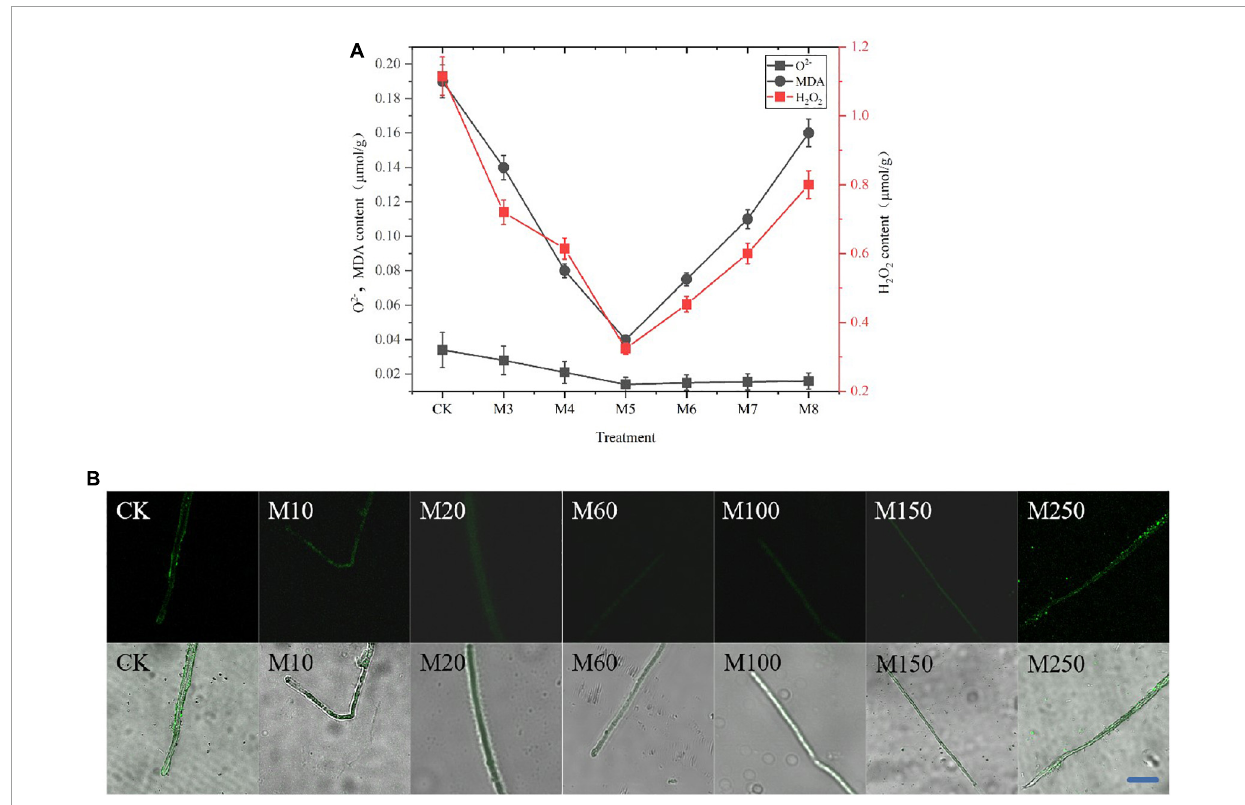
FIGURE2 Effects of MT on ROS, O 2 − , H 2 O 2 , and MDA levels in C. militaris. (A) O 2 − , H 2 O 2 , and MDA content. Bars indicate mean ± SD ( n = 3). The different letters represent significant differences among treatments according to Duncan’s multiple range tests ( p < 0.05), the same letters represent no significant differences among treatments. Data are represented as means ± SD, n = 3. The experiment was performed three times with similar results. (B) Observe the ROS in the mycelia of C. militaris after MT treatment by laser confocal microscope with DCFH-DA ROS fluorescence probe.